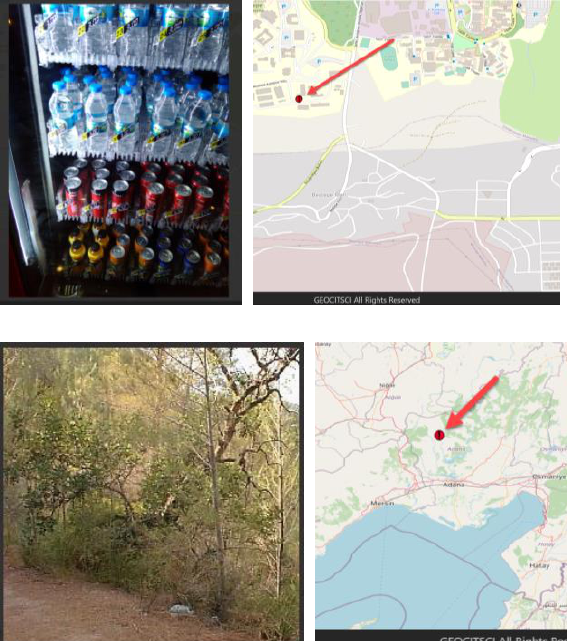
Figure 10. Examples to the user-provided photographs (left) together with their locations (right). The photos were classified as irrelevant in the image